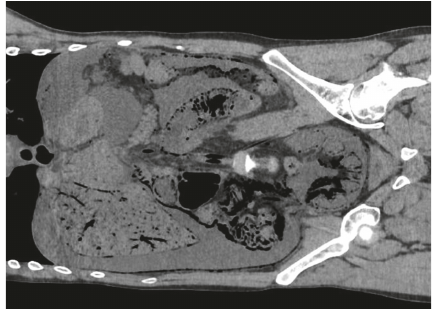
Figure 2: Postmortem CT, coronal view, pneumatosis intestinalis along the small bowel, right colon, and sigmoid, with gas in the portal system and blood vessels, with a large amount of unclear fluid around the liver and in the right paracolic